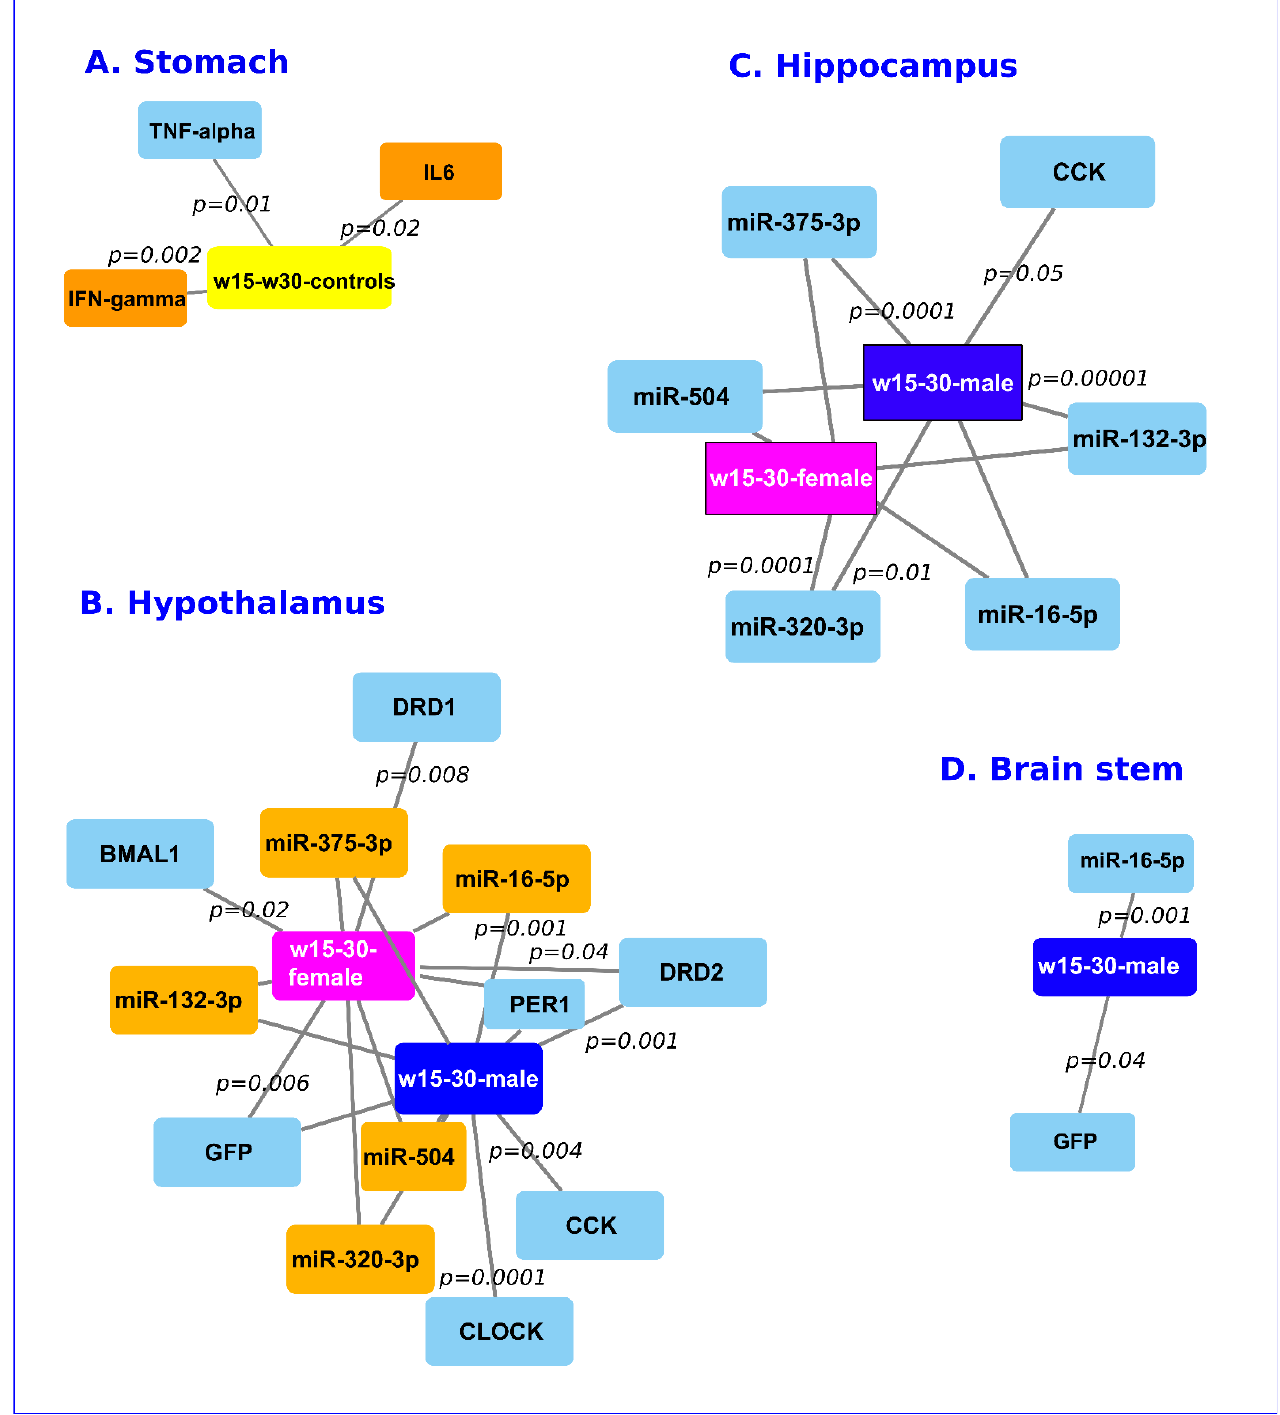
Figure 5. Network of genes significantly deregulated in the stomach wall ( A ), hypothalamus ( B ), hippocampus ( C ), and brain stem ( D ) of early and regularly weaned controls. Note on group nomenclature, for instance, “w15–w30” means a comparison between the early weaned controls with the regular weaning controls. No difference was found in the brain stem of female rats according to weaning schedule, and only miR-16-5p and gpf were downregulated in the brain stem of male rats. Edge length is inversely proportional to the p significant threshold. The p values are indicated in italic. Orange upregulated, blue downregulated.